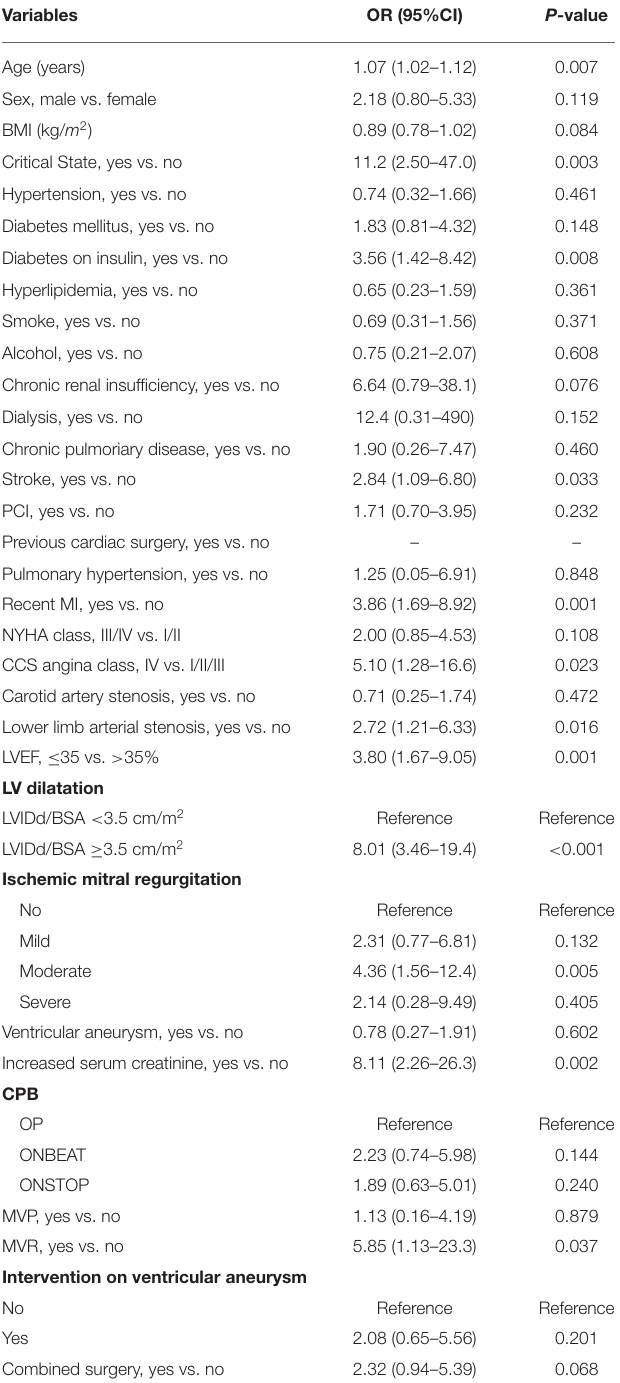
TABLE 3 | Multivariable logistic regression analysis of predictors associated with in-hospital mortality in the Training Cohort. Variable β coefficient OR (95% CI) P